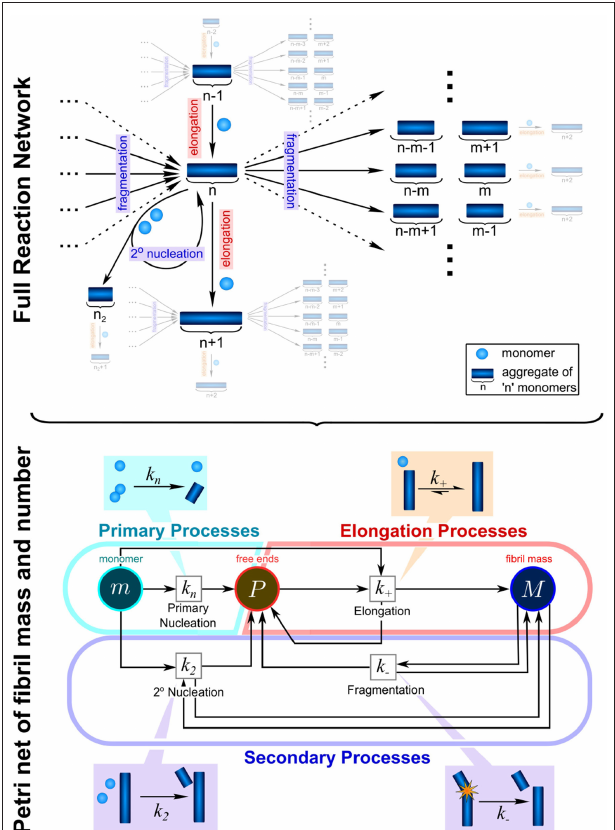
FIGURE 2 | Complexity of reaction network can be significantly reduced by the introduction of moments. To fully describe the aggregation reaction one must account for how all the different sizes of aggregate can interact and inter-convert, leading to a highly complex reaction network with many thousands of possible species and reactions. This network can be enormously simplified by instead considering only the moments of the fibril length distribution, the aggregate number concentration, P , and the aggregate mass concentration, M . While some information about the detailed size distribution is lost in this step, the description of the system in terms of its moments is usually sufficient to fully describe most experimental data and to extract the rate constants of interest: k n , k 2 , k − , and k + . These are the rate constants of primary nucleation, secondary nucleation, fragmentation, and elongation, respectively. Adapted from Meisl et al.